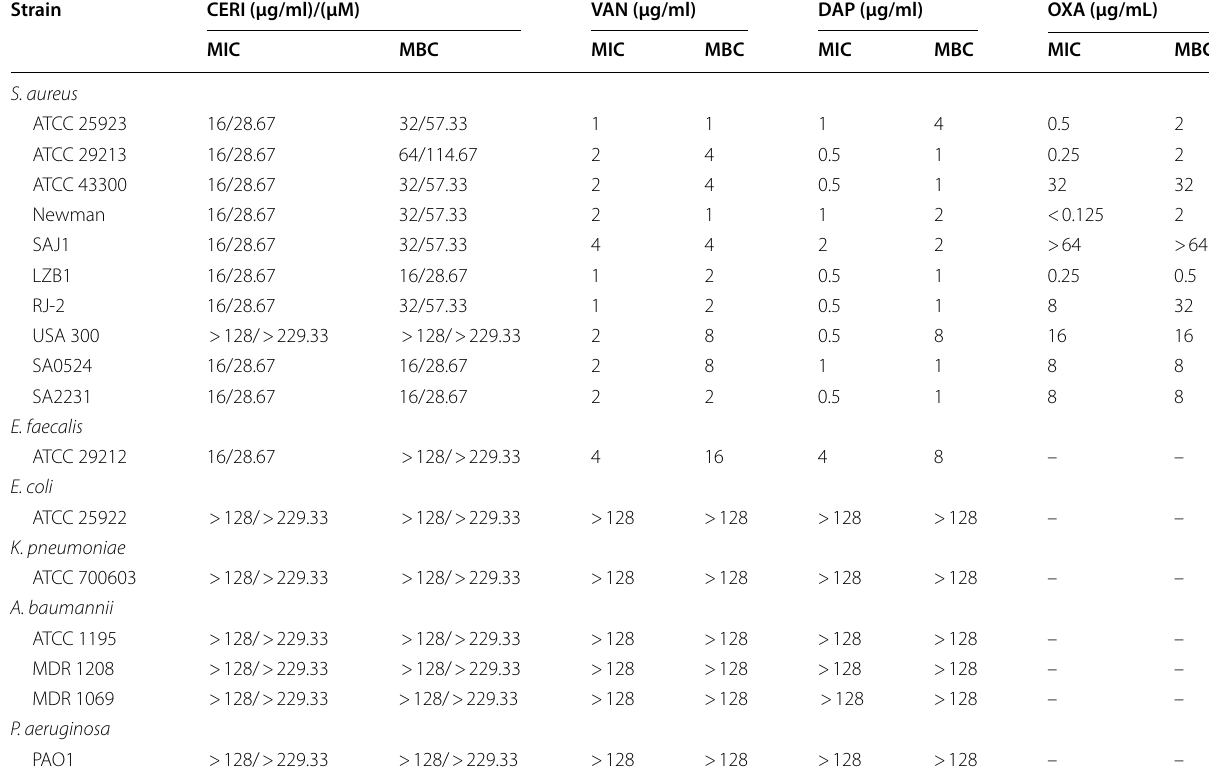
Table 1 Antimicrobial susceptibility of CERI, VAN, OXA and daptomycin against Gram-positive and Gram-negative pathogens